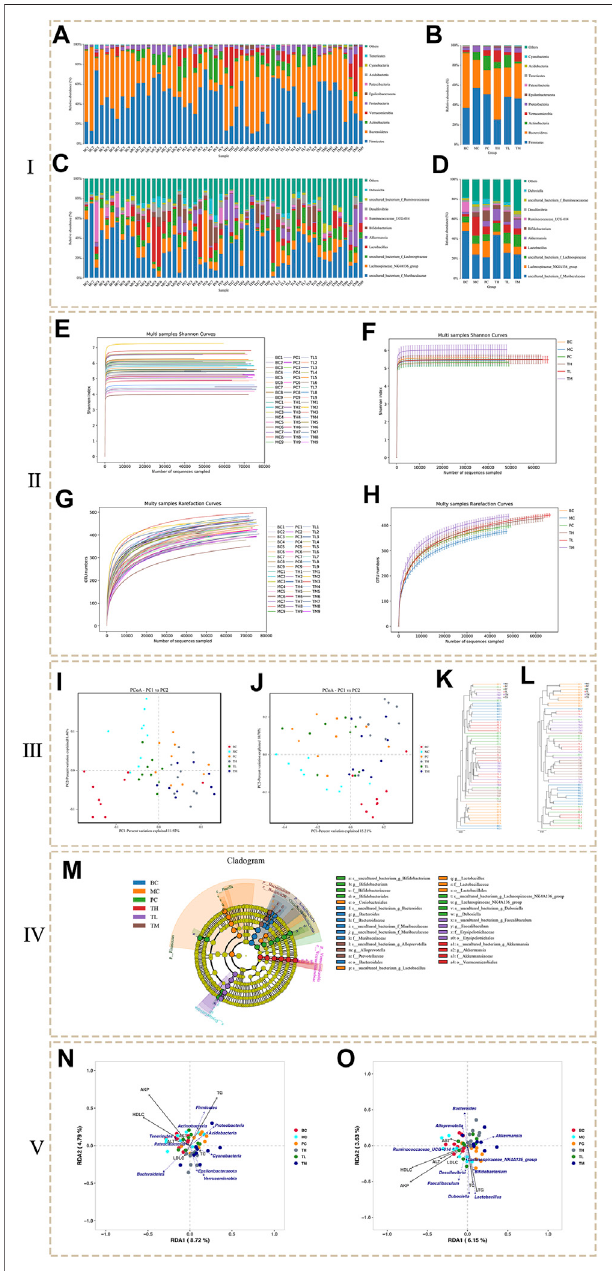
FIGURE 3 | The results of microbial diversity analysis. ( Ⅰ : Histogram of species distribution. Ⅱ : Dilution curve and Shannon curve. Ⅲ : Beta analysis based on OTU. Ⅳ : LEfSe analysis. Ⅴ : RDA